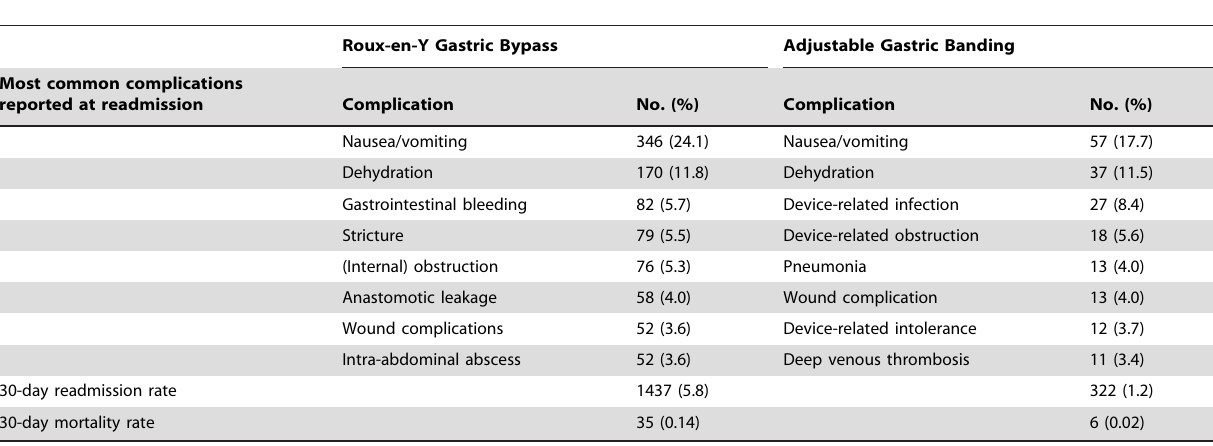
Table 3. Common Complications at Readmission by